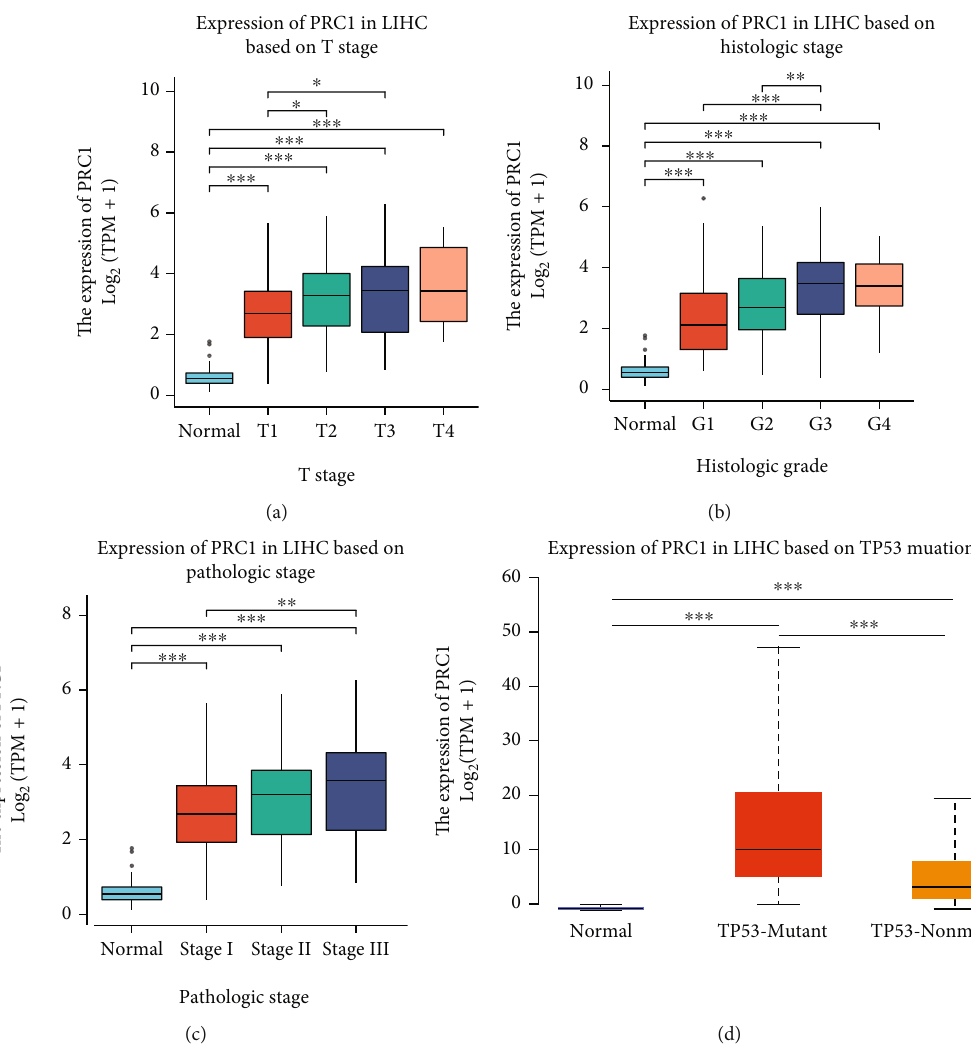
Figure 3: PRC1 expression among di ff erent groups of patients based on clinical parameters. Analyses are shown for T stage (a), histologic grade (b), pathologic stage (c), and TP53 mutant status (d). ∗ p < 0 : 05 ; ∗∗ p < 0 : 01 ; ∗∗∗ p < 0 : 001